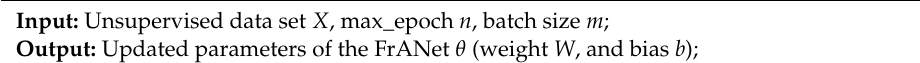
Algorithm 1. The pseudocode for training the FrANet using an unsupervised data